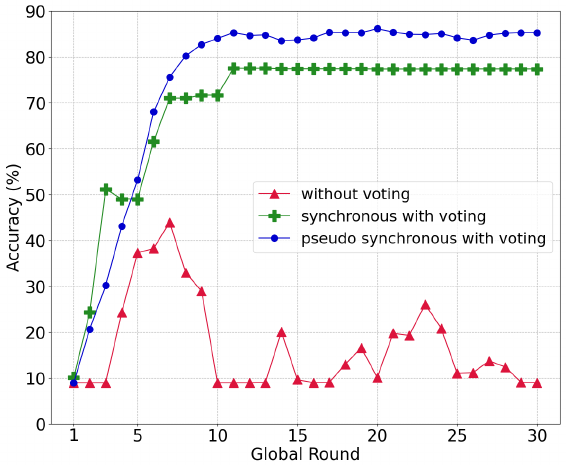
Figure 8. Global model accuracy under different voting